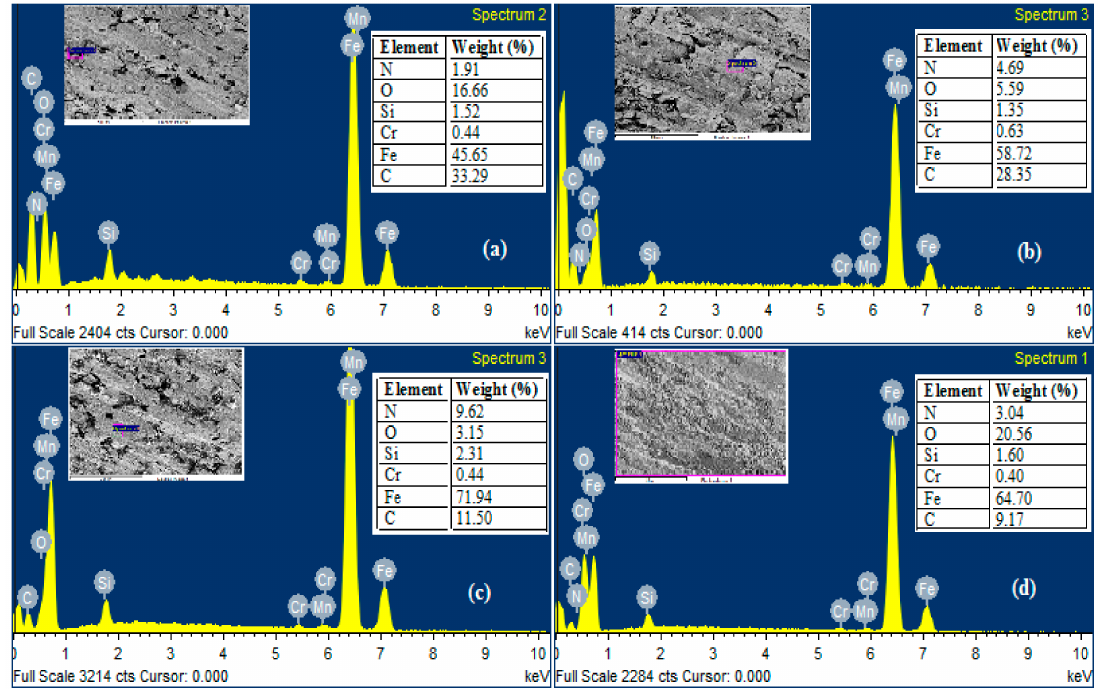
Figure 12. EDS spectra of counter-body: ( a ) wear track of counter-body at 28 ◦ C, ( b ) wear track of counter-body at 100 ◦ C, ( c ) wear track of counter-body at 200 ◦ C, ( d ) wear track of counter-body at 300 ◦